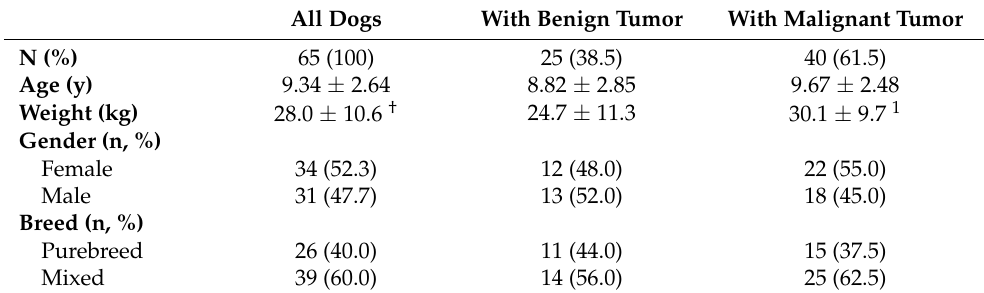
Table 3. Patient demographics for adult dogs diagnosed with cancer. Data are represented as absolute counts or as mean ± SD. All Dogs With Benign